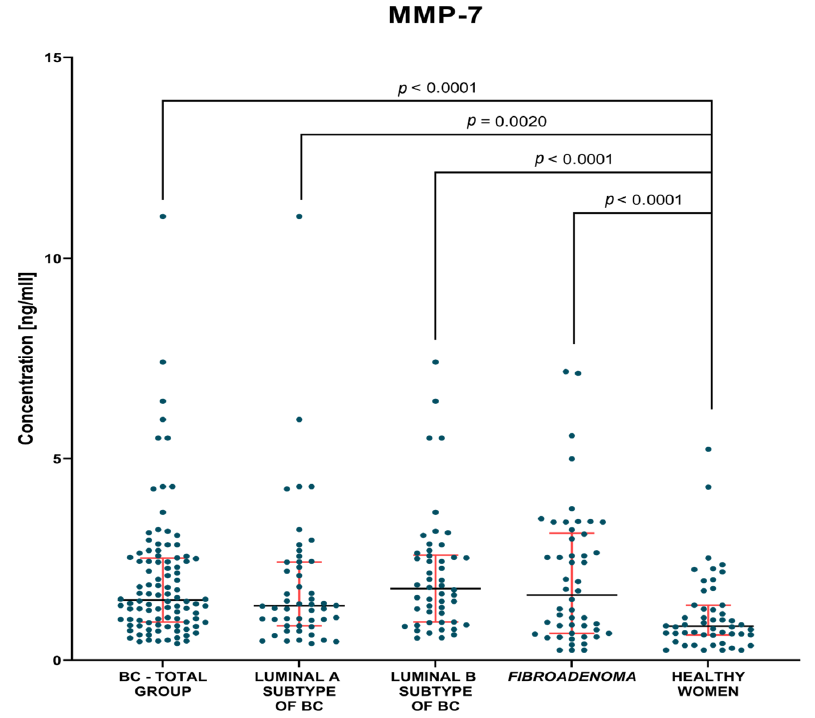
Figure 2. MMP-7 plasma concentrations (with marked median and interquartile range) in all tested groups: patients with BC, fibroadenoma subjects and healthy women. Significant statistical differences have been marked on the figure.